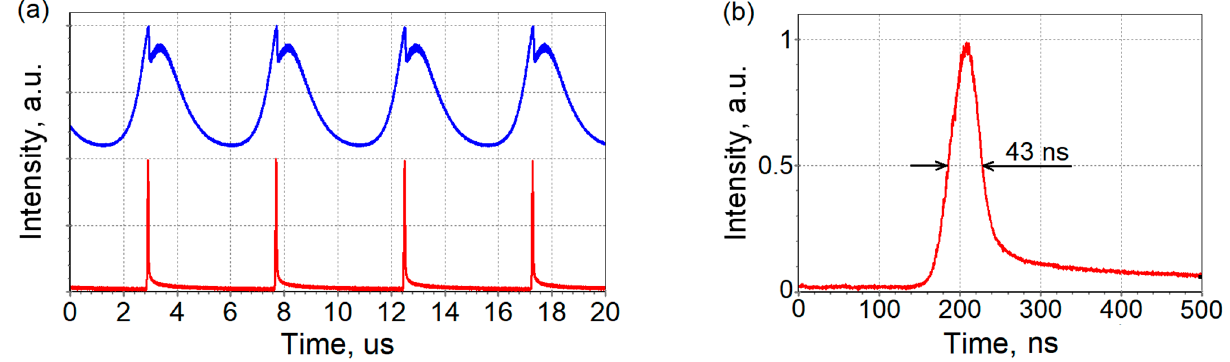
Figure 7. ( a ) Synchronously measured time traces of the laser pulse trains obtained at the fundamental (upper trace) and Stokes (lower trace) wavelengths upon a quasi-synchronous pumping with the modulation frequency of 208.8 kHz; ( b ) measured high-resolution time trace of a single laser pulse at the Stokes wavelength.